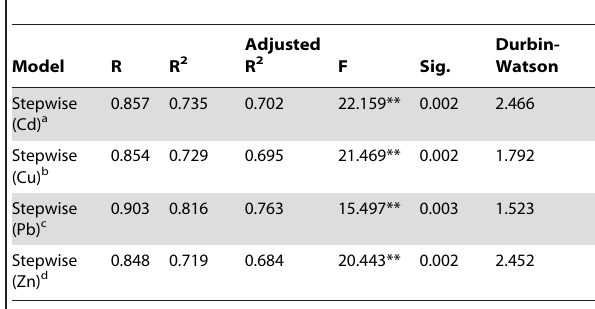
Table 7. The results of the global test of regression